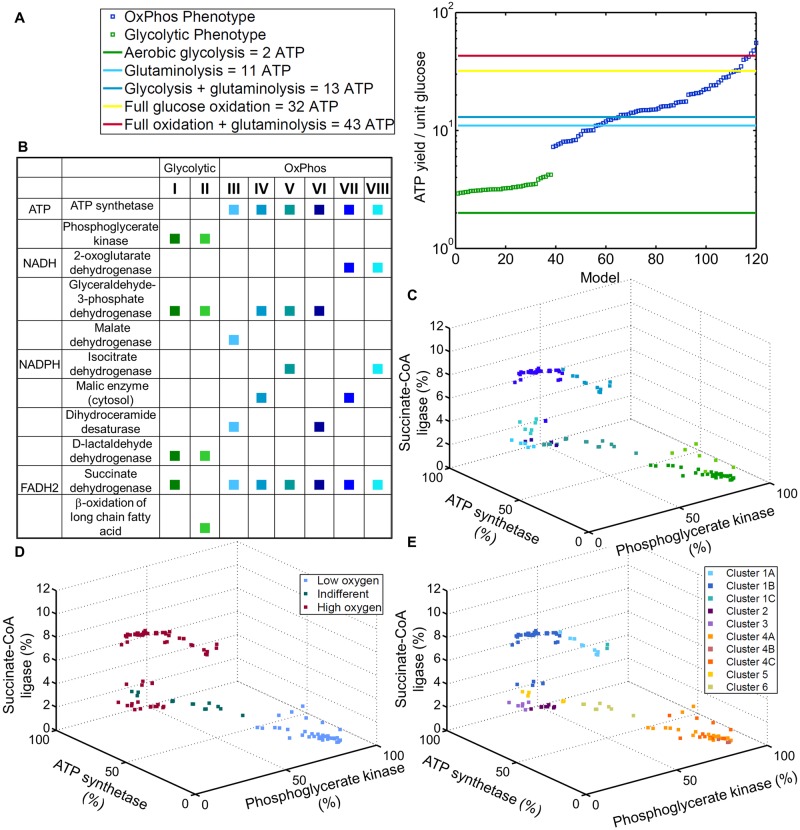
Distinction of the models.A Rank-ordered ATP yields achieved by the models describe a gradual increase rather than clusters around theoretical ATP yields. The spread of ATP yields highlights the metabolic heterogeneity between the 120 models. The cell lines use a mixture of pathways and metabolic fuels for ATP production, which explains that the predicted ATP yield can exceed the theoretical measures. Two major strategies for ATP production can be distinguished based on the ATP yields. The distinction lies in the higher contribution of either phosphoglycerate kinase (green squares) or ATP synthase (red squares) to the total ATP production. B A fine-grained division of the OxPhos models is achieved considering the production strategies of ATP, NADPH, NADH, and FADH2. The table lists the reactions contributing most to ATP, NADH, NADPH, and FADH2 production for each phenotype (I-VIII). C A three dimensional plot of the eight phenotypes with respect to the utilization of glycolysis, the TCA cycle, and oxidative phosphorylation. D Three different oxotypes are distinguished. The distinction between the OxPhos models (blue) is different from the phenotypic classification performed based on the energy and cofactor production strategies depicted above (see also S1 Text). E Six model clusters are distinguished according to each models’ ability to deal with environmental changes. Variations in glucose, glutamine, lactate, and oxygen lead to a distinct stratification of OxPhos models. Fig F in S1 Text shows different perspectives.